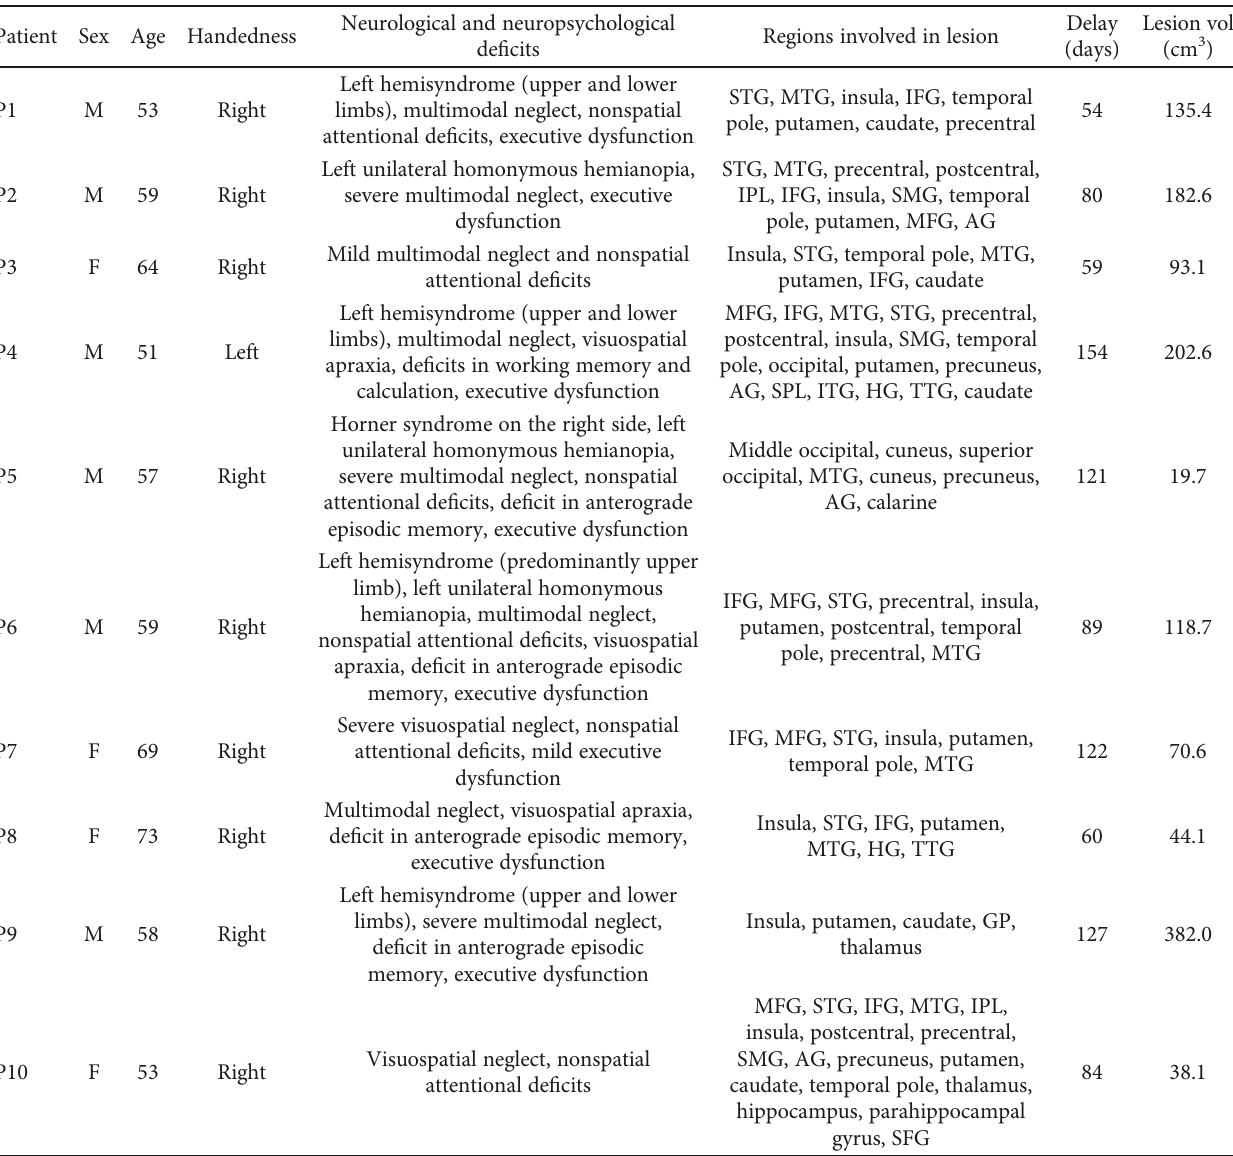
Table 1: Patients ’ characteristics including the delay between the stroke and the testing session. STG: superior temporal gyrus; MTG: middle temporal gyrus; IFG: inferior frontal gyrus; IPL: inferior parietal lobule; SMG: supramarginal gyrus; AG: angular gyrus; SPL: superior parietal lobule; ITG: inferior temporal gyrus; HG: Heschl gyrus; TTG: transverse temporal gyrus; GP: globus pallidus; SFG: superior frontal